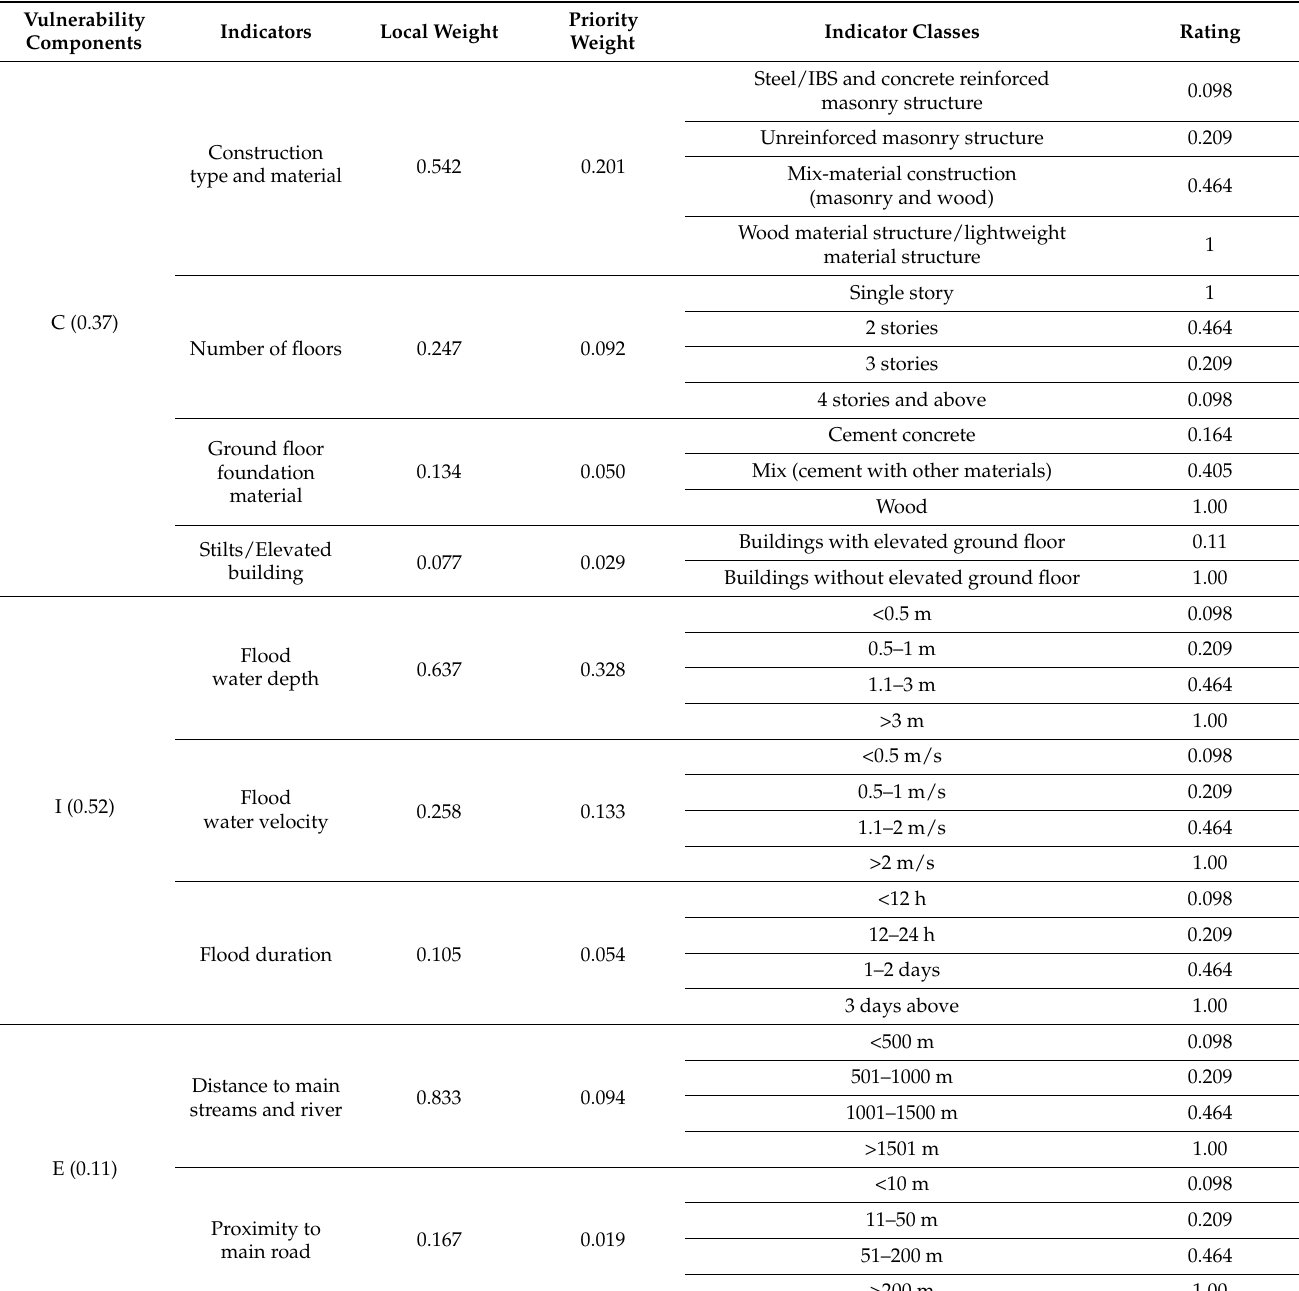
Table 4. Priority weights of indicators and indicator classes